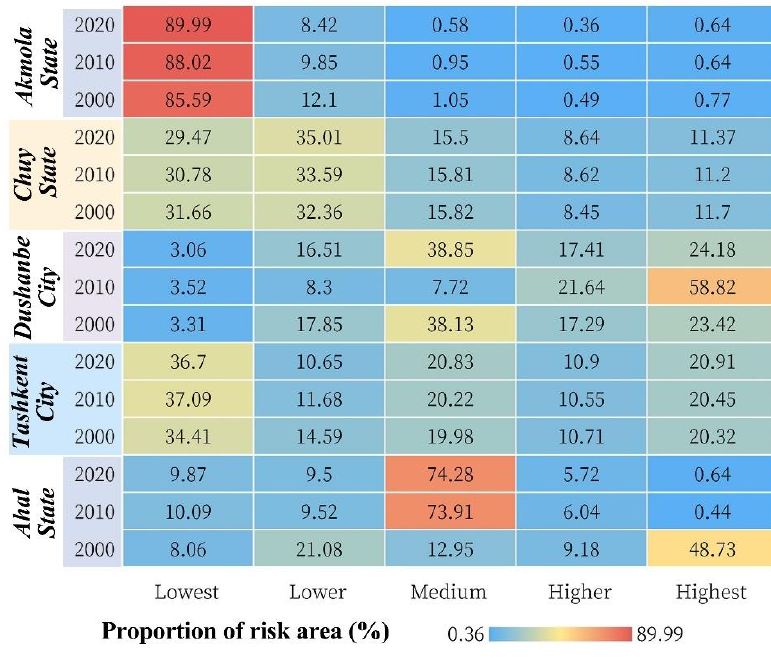
Figure 8. Proportion of different grades of ecological risk areas.